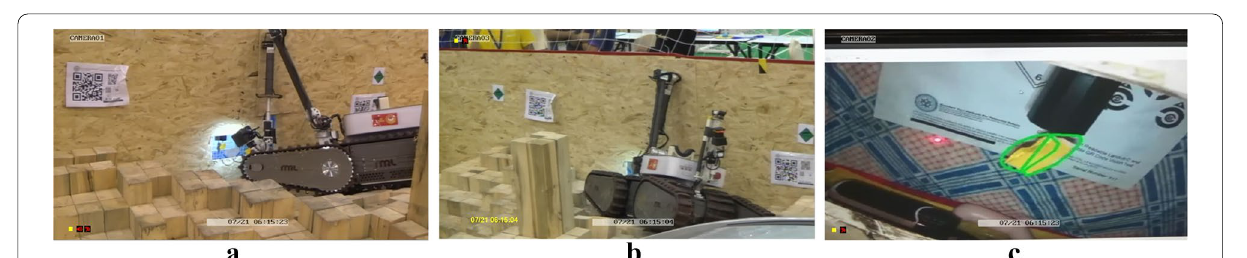
Fig. 23 Karo is inspecting a victim’s hole in highly uneven